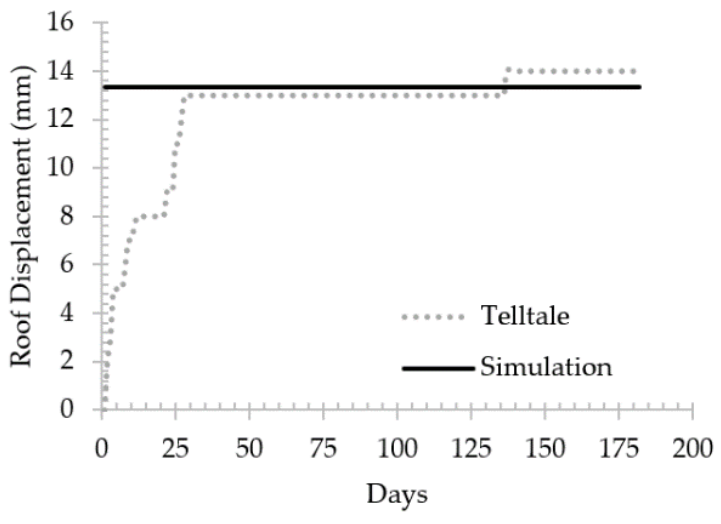
Figure 8. Comparison between telltale results and simulation results.